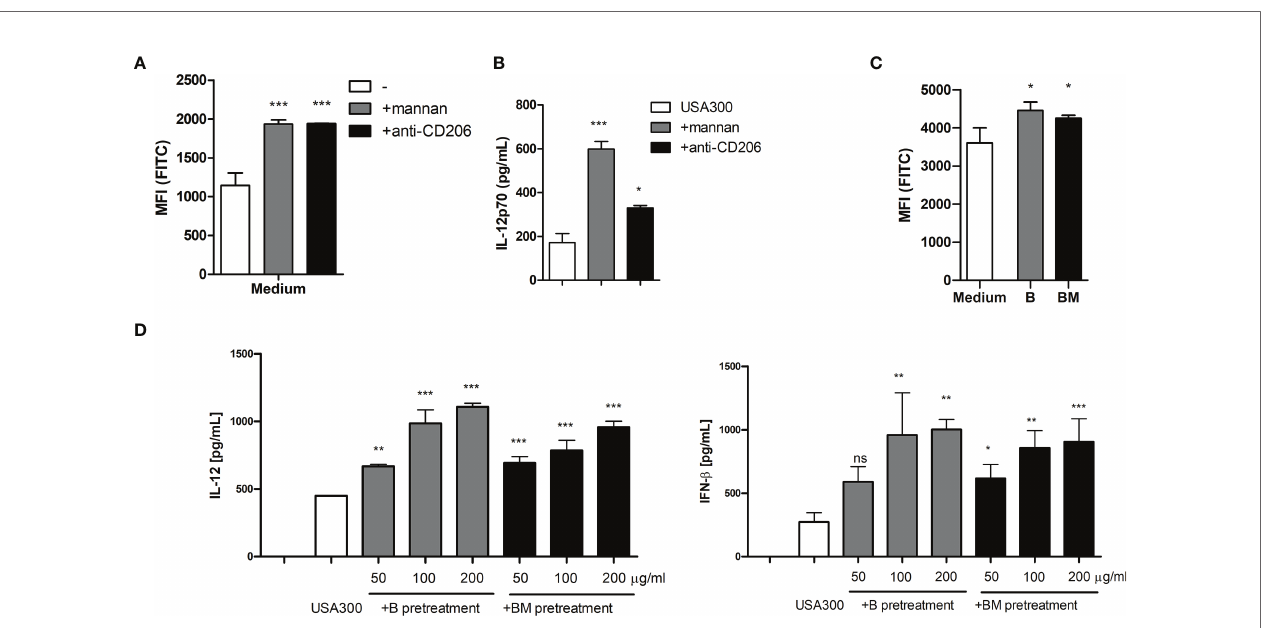
FIGURE 6 | Anti-MR antibody and soluble b -glucan also enhances MRSA induced IL-12 and ROS production. Pre-treatment with mannan or with a monoclonal antibody against the mannose receptor (anti-CD206) both induced increased ROS production in DCs (A) and enhanced the IL-12 production induced by USA300 (B) . Two preparations of soluble b -glucan isolated from barley induced increased ROS (C) and enhanced the USA300 induced IL-12 and IFN- b (D) . For all experiments n=3 +/- SD. One-way ANOVA, *p < 0.05, **p < 0.01, ***p < 0.001, ns, non signi fi cant. All data represent one out of at least two independent